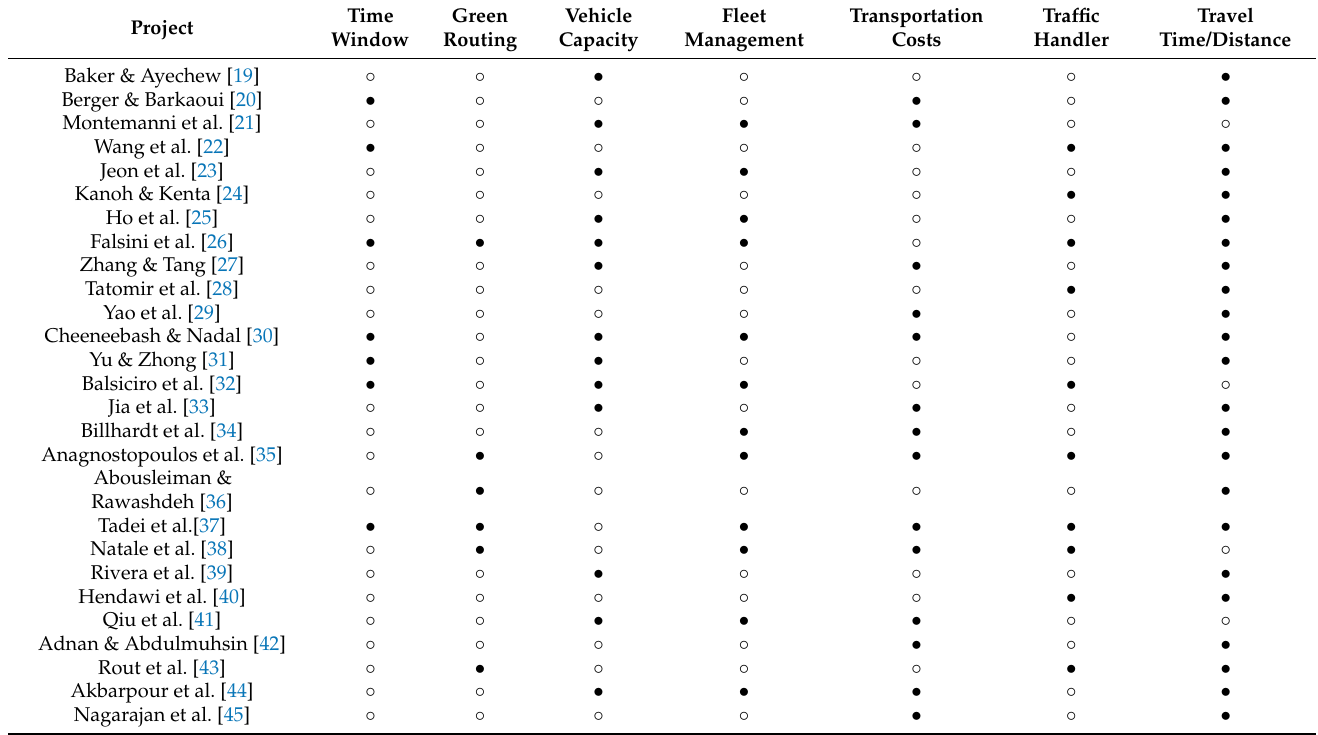
Table 1. Routing Services Features Comparison